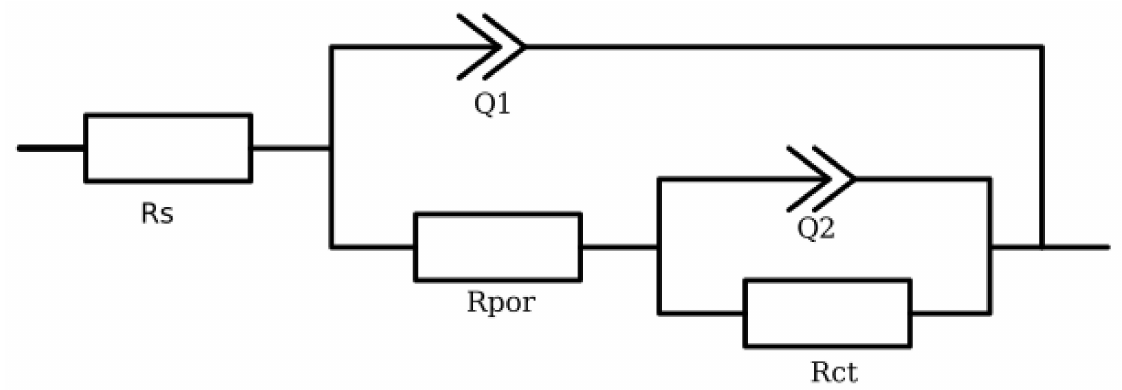
Figure 11. Electrical circuit model for the impedance of PBSLP adsorbed onto the mild steel